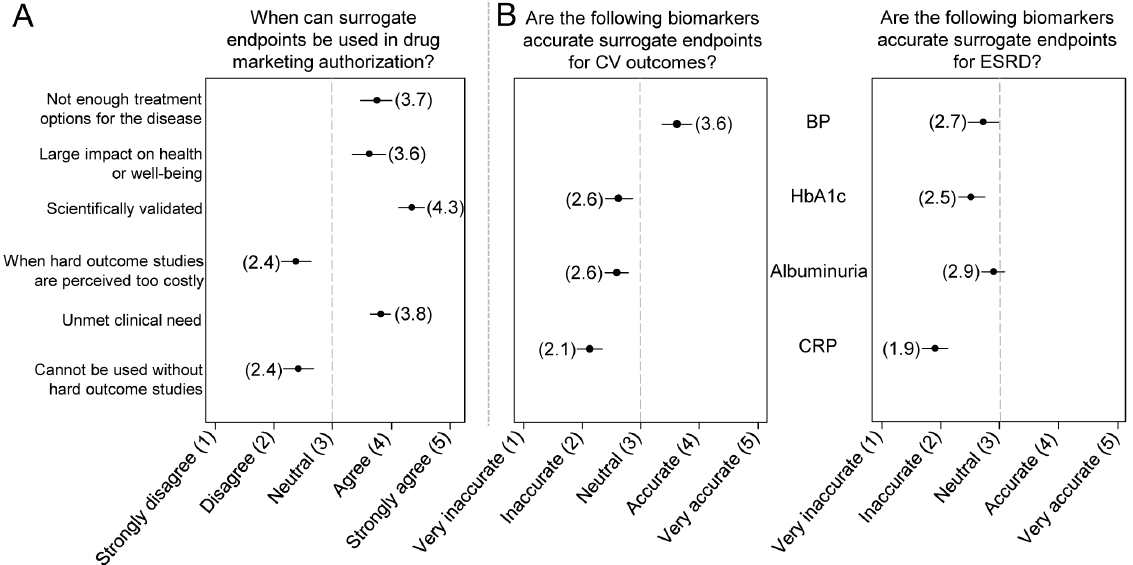
Figure 1. Pooled responses to survey questions. A: pooled responses (mean + 95% CI) of all stakeholders on when surrogate endpoints can be used in drug marketing authorization, provided that a post-marketing study with hard outcomes is conducted. B: pooled answers on which biomarkers are perceived as accurate surrogate endpoints for either cardiovascular outcomes or end-stage renal disease. Absolute mean values are provided in brackets. Abbreviations: CV, cardiovascular; ESRD, end-stage renal disease; BP, blood pressure; CRP, C-reactive protein.